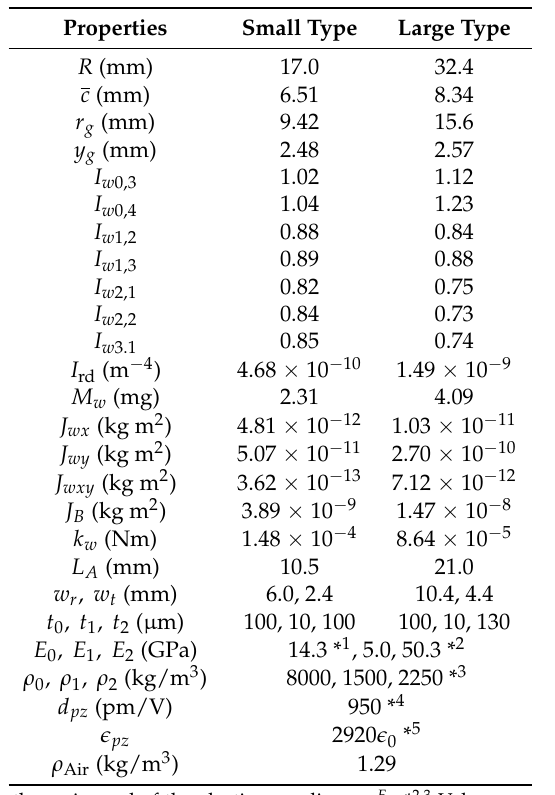
Table A1. Material properties, geometric parameters, and masses/inertias of fabricated